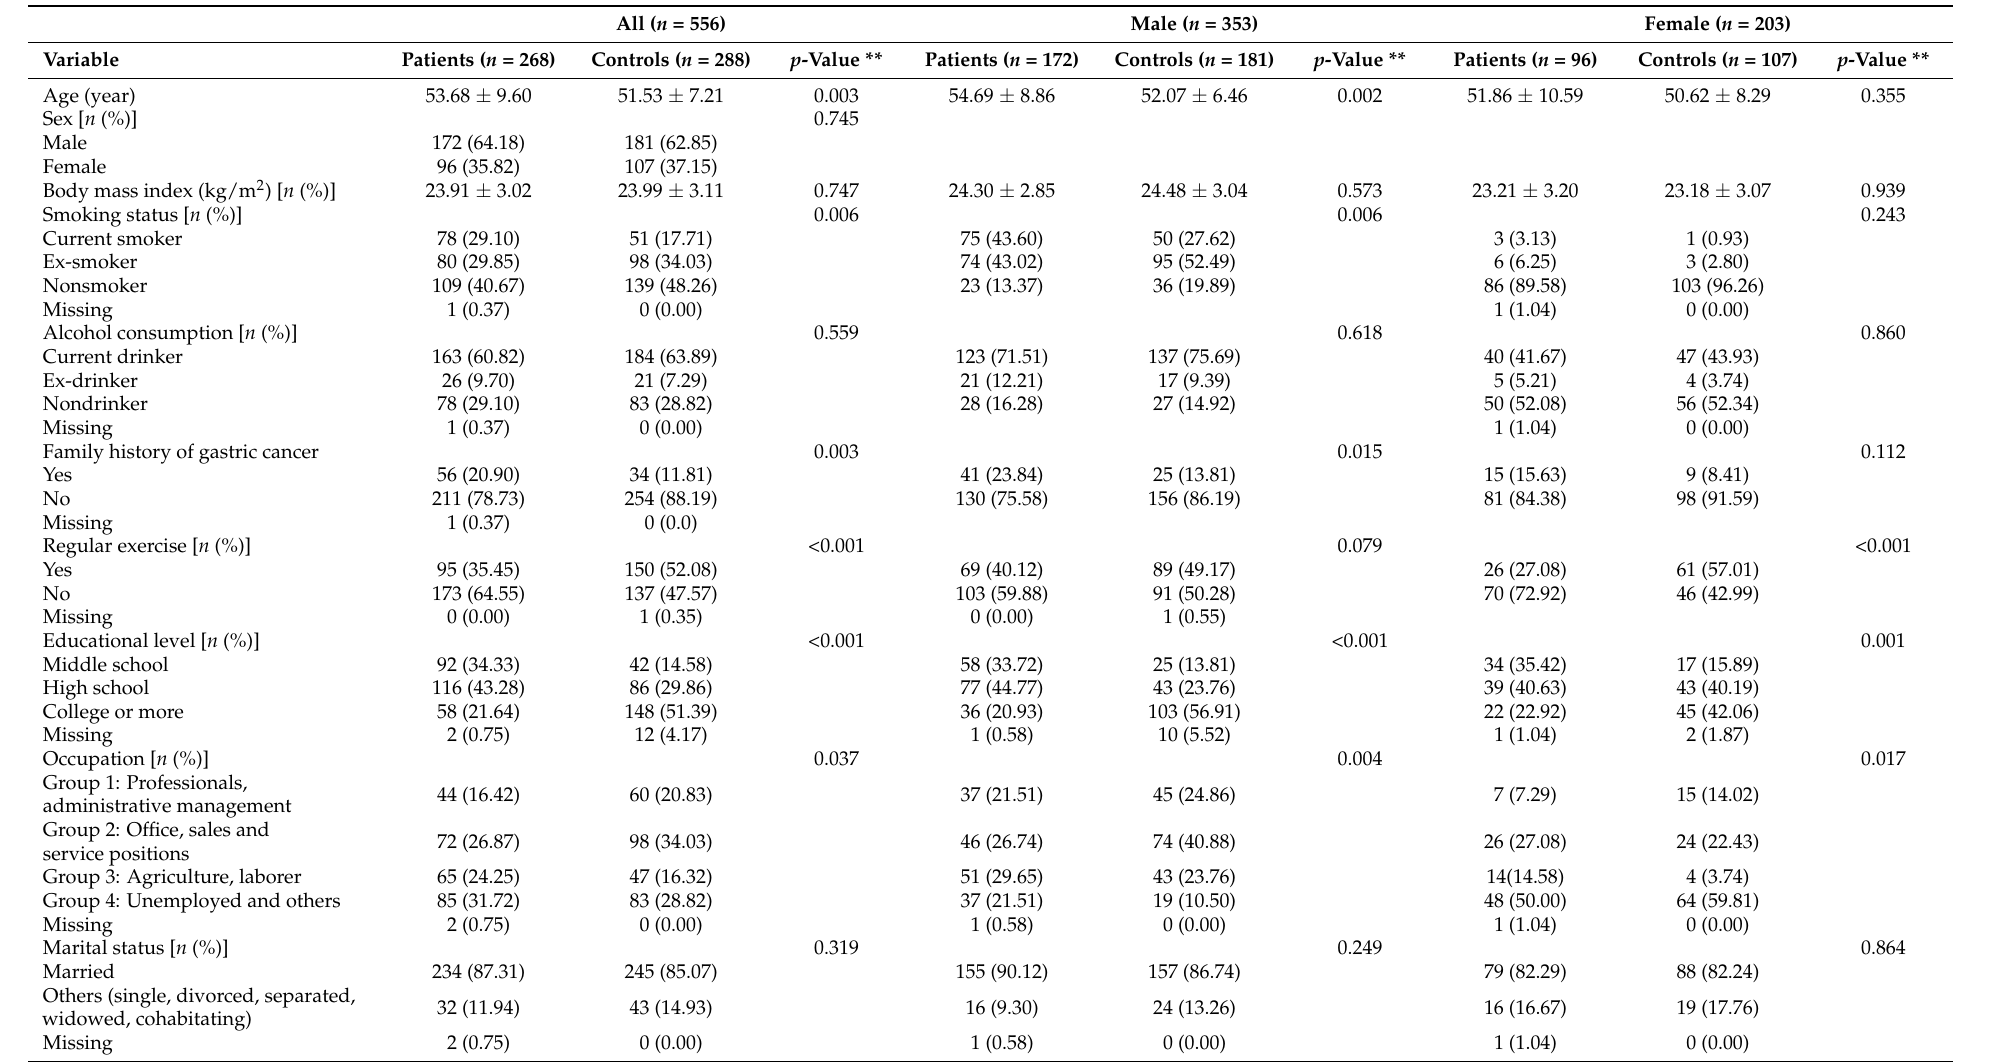
Table 1. General characteristics of the study